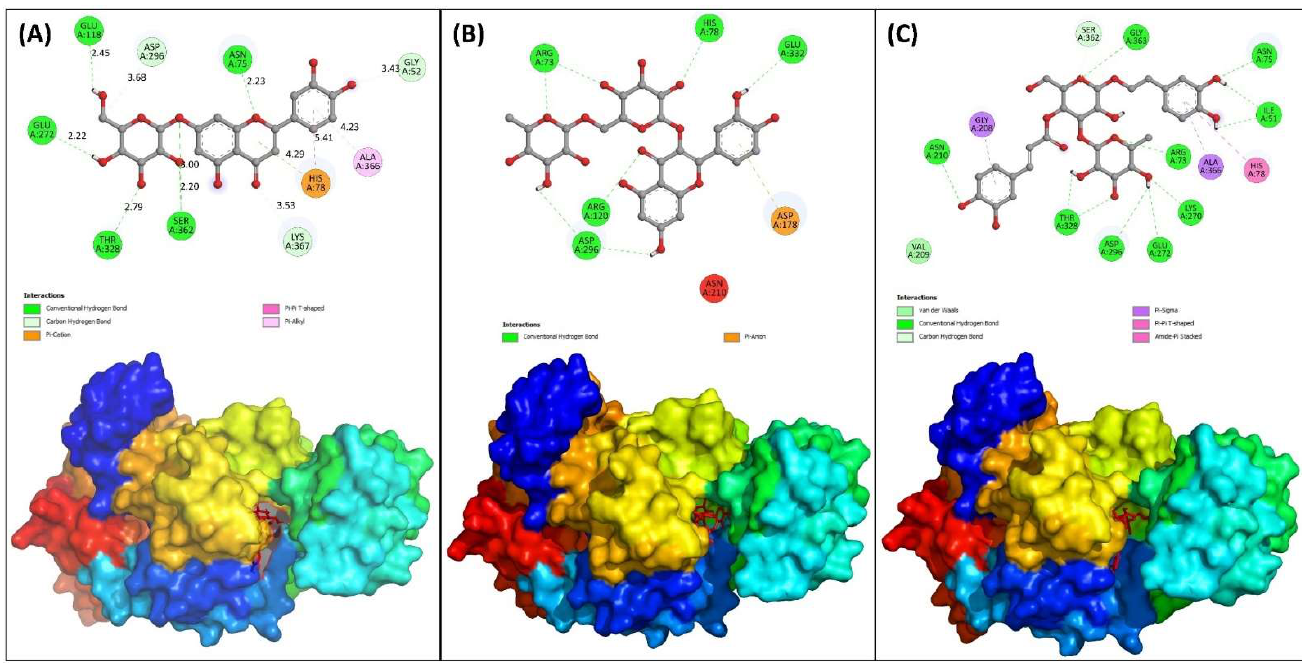
Figure 1. 2D and 3D representation of the docked structures of the top three lead molecules